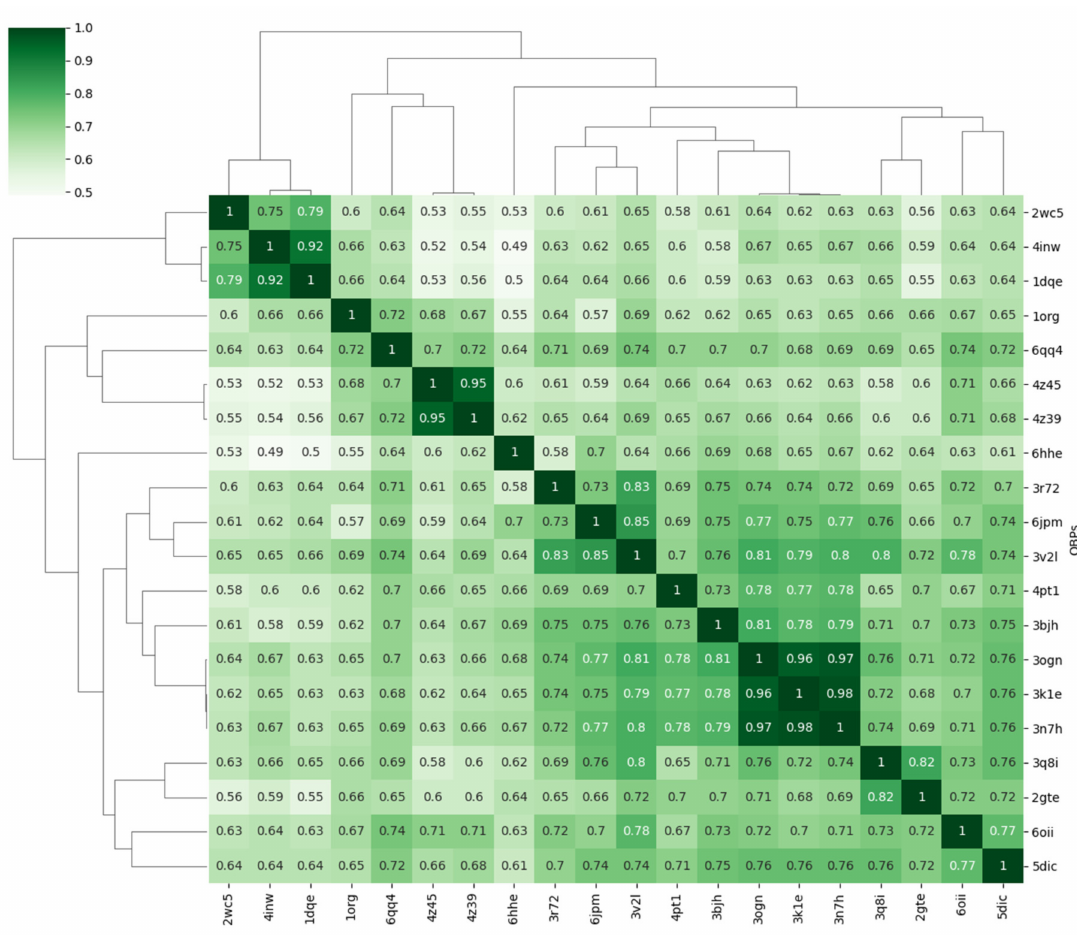
Figure 7. Dynamics-based hierarchically-clustered heatmap. The heatmap is represented such that each structure pairs with all others, including itself. This gives a diagonal with the maximum score of 1.0. The dendrogram was obtained using hierarchical clustering obtained from a complete linkage clustering with Euclidian